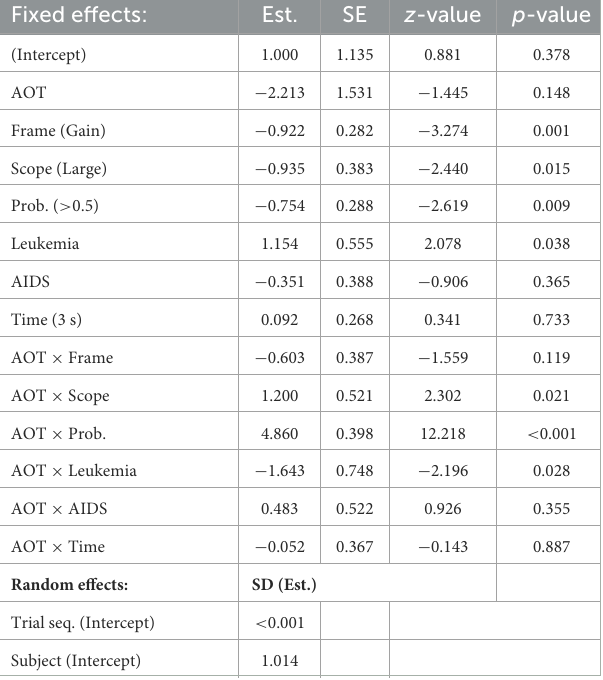
TABLE 3 Experiment 1: Generalized linear mixed model, Interactions: actively open-minded